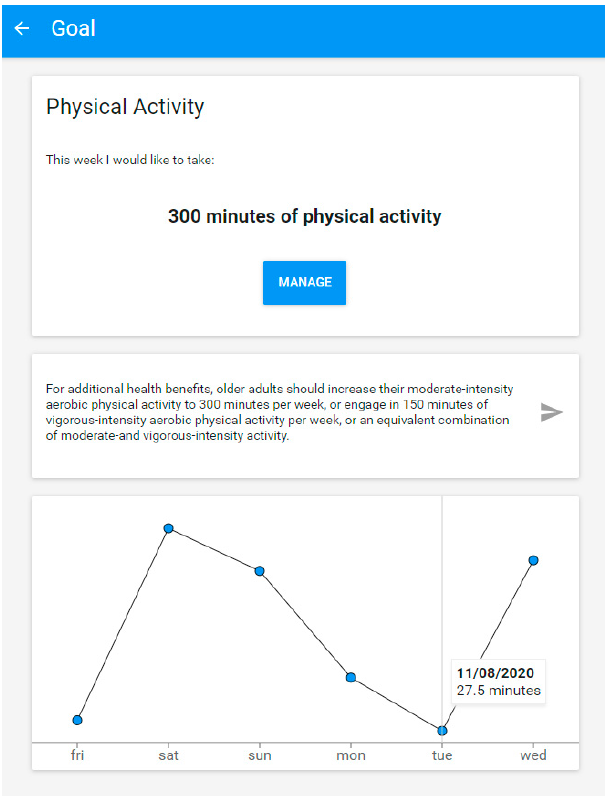
Figure 9. The goals interface.